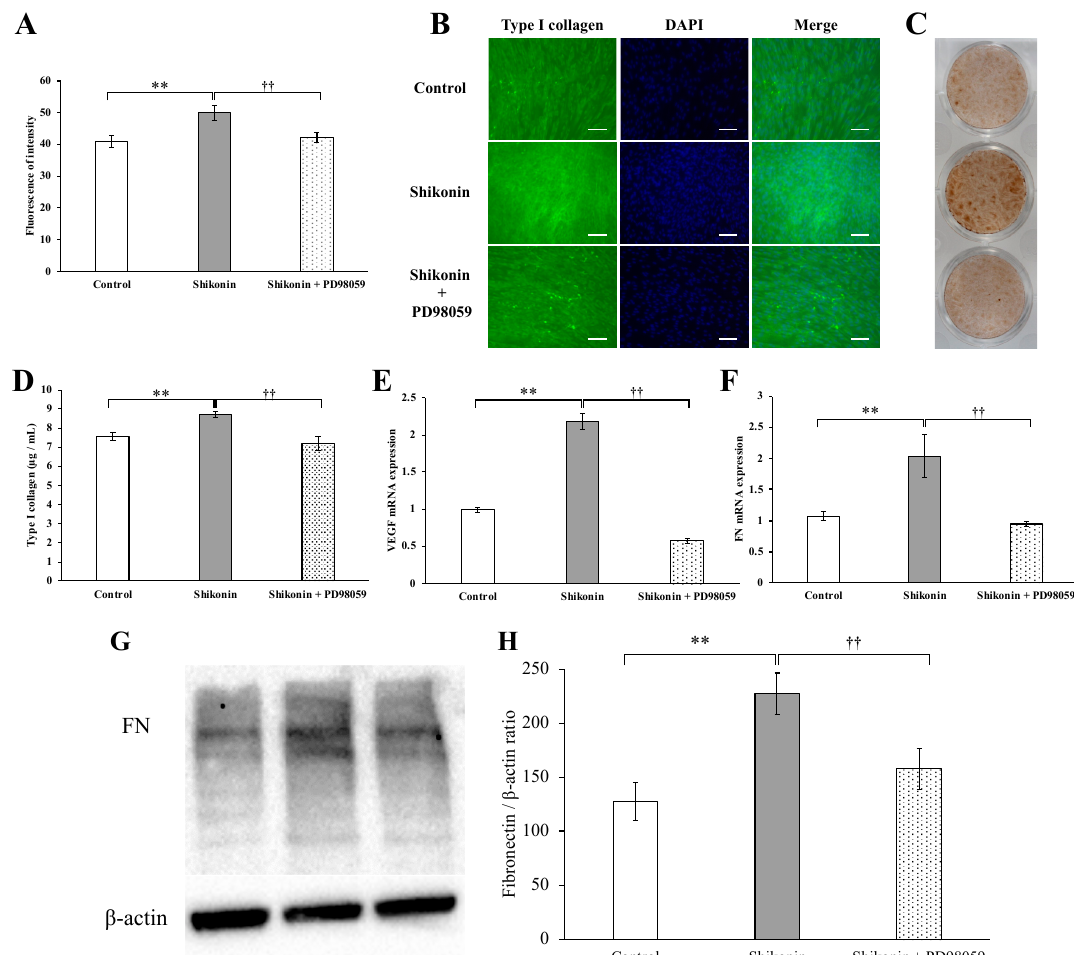
Figure 6. Effect of PD98059 on type I collagen synthesis stimulated by shikonin in human gingival fibroblasts. Type I collagen synthesis was determined by ( A ) fluorescence immunostaining and ( B ) fluorescence microscopy. (scale bar = 500 μ m). ( C ) The effect of PD98059 on type I collagen synthesis was also analyzed by chromogenic immunostaining and photographed using a single-lens reflex camera. ( D ) Type I collagen in the cell culture supernatant after treatment for 1 week was measured by using ELISA. ( E , F ) Effect of PD98059 on the expression of VEGF and FN stimulated by shikonin in hGFs. Gene expression was determined by PCR. ( G ) Protein expression of FN was evaluated by immunoblotting analysis. ( H ) The quantification was performed using image analysis software. (** p < 0.01, control vs. 1 μ M shikonin; †† p < 0.01, 1 μ M shikonin vs. 1 μ M shikonin + 20 μ M PD98059).